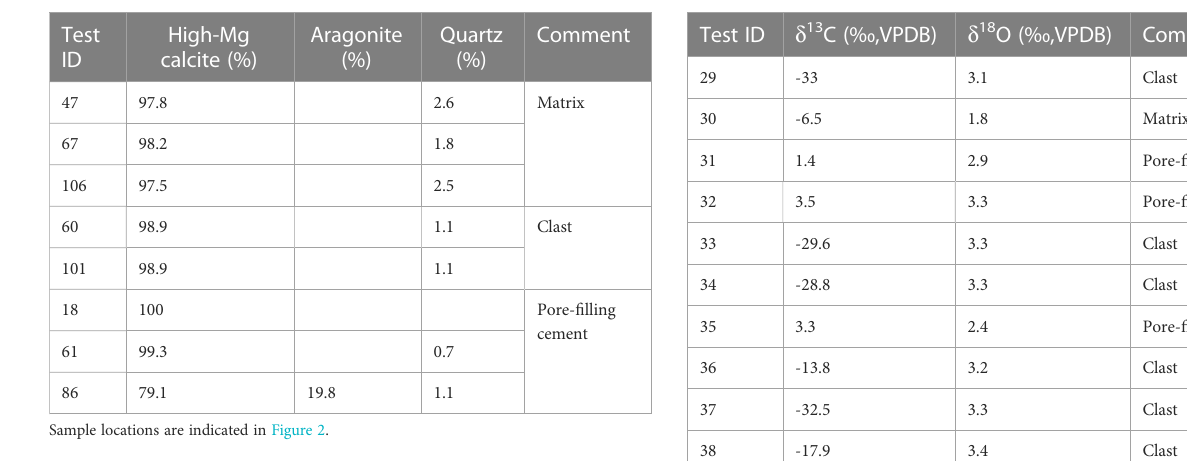
TABLE 1 Mineral composition of the seep carbonate.